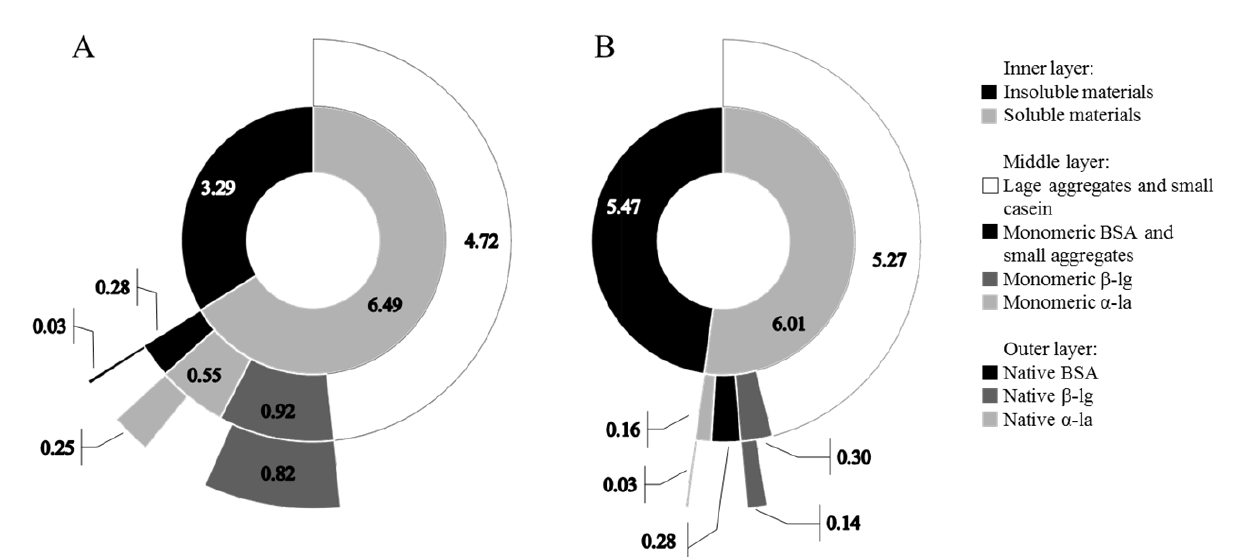
Figure 3. ( A ) Membrane-filtered infant milk formula (MEM-IMF) and ( B ) high-heat-treated infant milk formula (HT-IMF). Inner layer: amount of soluble materials (light gray) and insoluble materials (black), g 100 g −1 IMF powder; Middle layer: amount of different molecular weight (Mw) distribution (g 100 g −1 IMF powder), large aggregates and small casein particles (100 to 500 kDa, white), monomeric BSA and small aggregates (30 to 100 kDa, black), monomeric β -lg (16 to 25 kDa, dark gray), and monomeric α -la (9 to 16.5 kDa, light gray); Outer layer: amount of native whey proteins (g 100 g −1 IMF powder), native BSA (black), native β -lg (dark gray), an d native α -la (light gray).